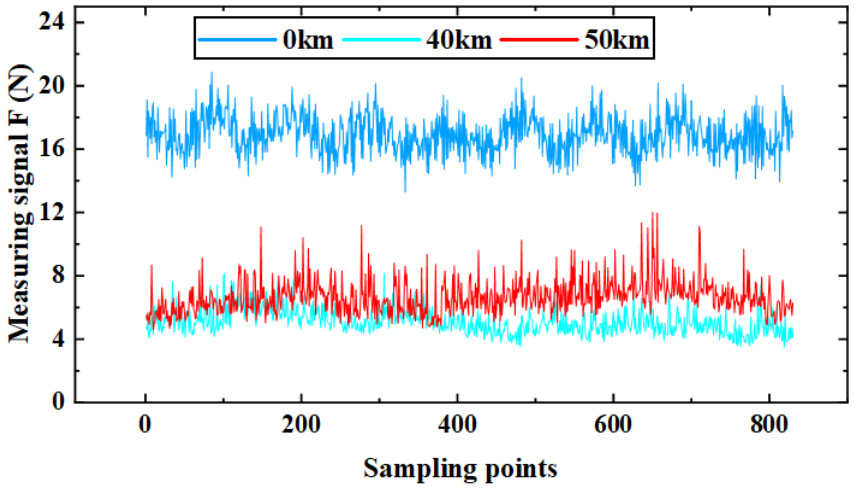
Figure 7. Preload drag force degradation curve.